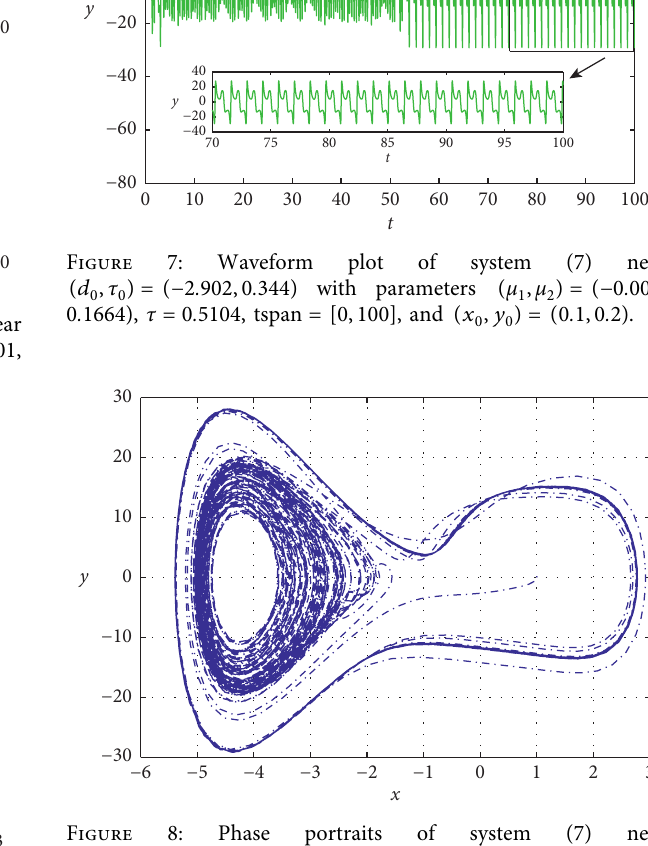
, μ ) � (− 0 . 001 , 1 2 ,y ) � ( 0 . 1 , 0 . 2 ) . 0 0